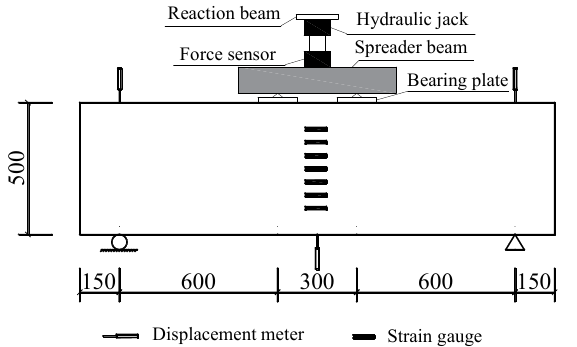
Figure 5. Test setup of DSRC deep beams.